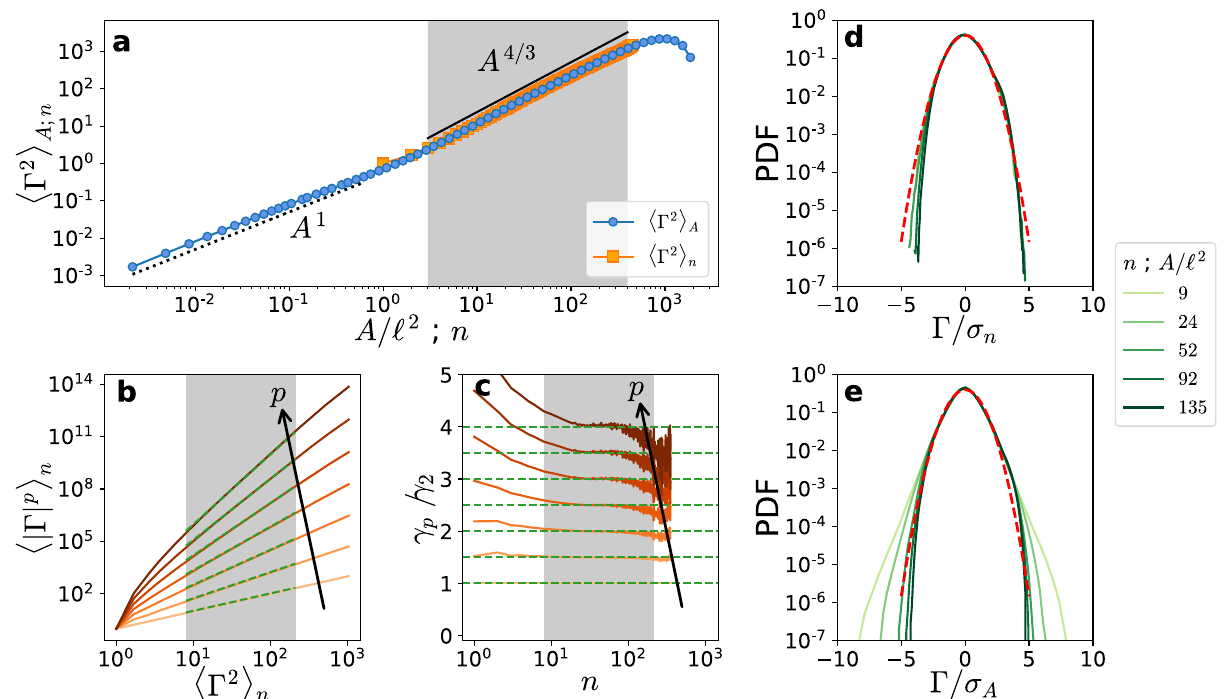
Fig. 3 Circulation statistics in quantum turbulence. a Circulation variance as a function of the area A of each loop and of the number n of neighbouring vortices. The dotted line represents the scaling A 1 observed at small scales of quantum turbulence 13 . b , c Moments and local slopes of hj Γ j p i n as a function of h Γ 2 i n according to the ESS approach, for p ∈ [2, 8]. Dashed green lines represent the K41 scaling γ p = 2 p /3. d , e PDFs of the circulation for different ( d ) numbers of vortices and ( e ) loop areas. All PDFs are normalised by the respective standard deviations. Dashed red lines represent a unit Gaussian